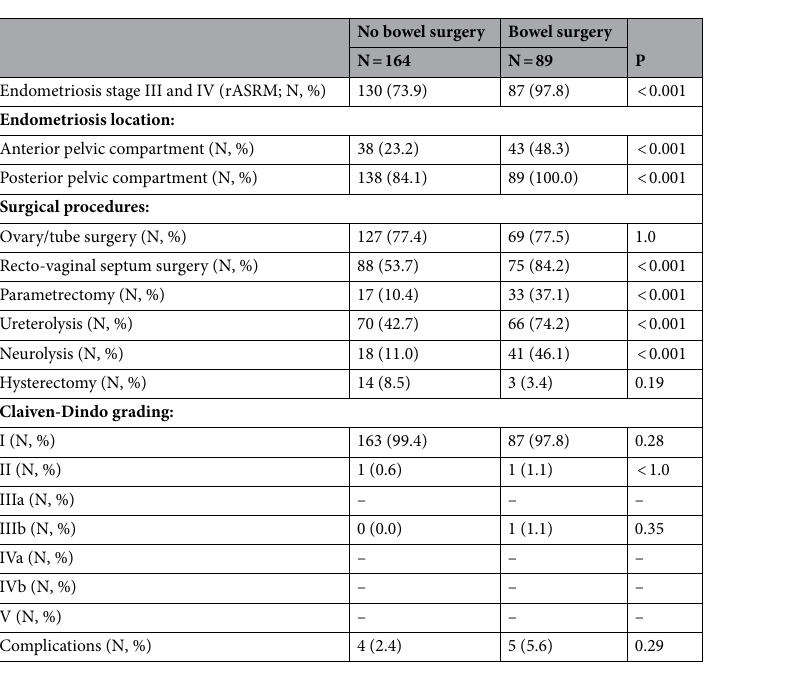
Table 2. Surgical details in the two